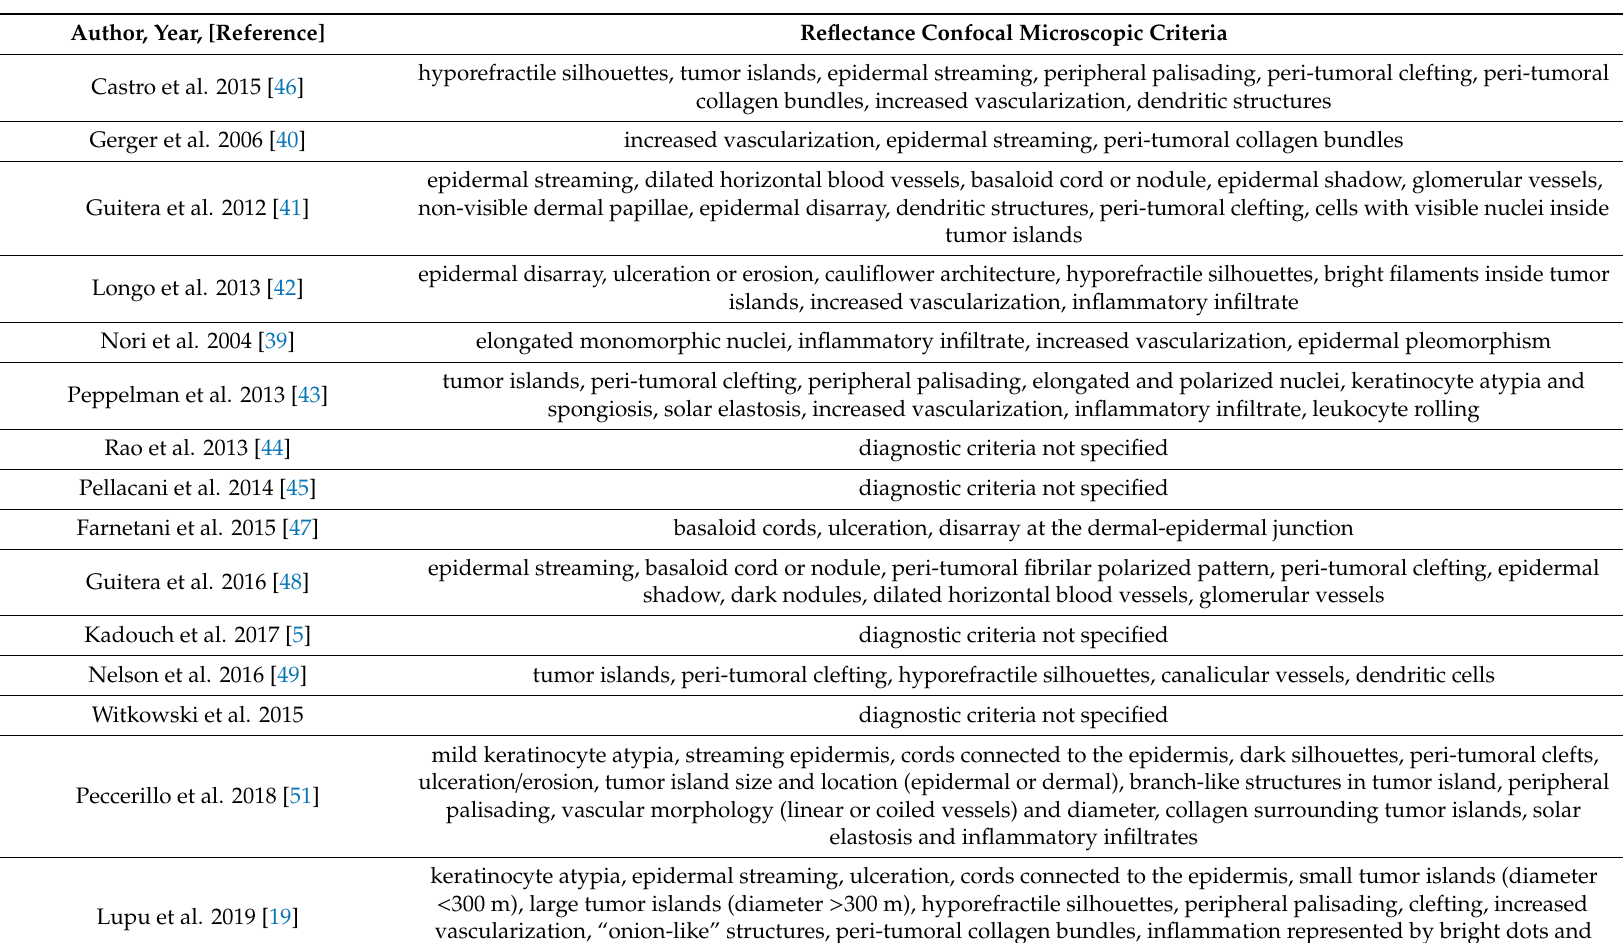
Table 2. Criteria for the diagnosis of basal cell carcinoma in the included